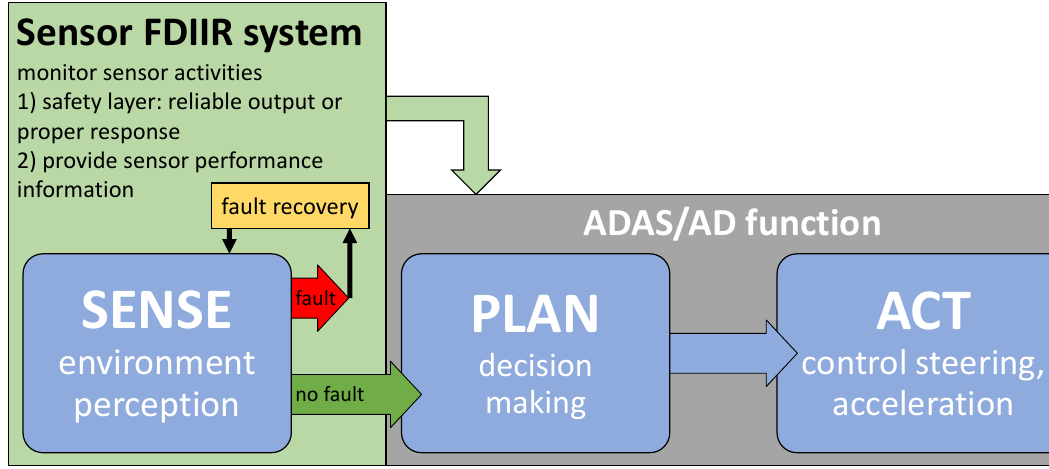
Figure 1. Schematic illustration of the sense-plan-act cycle including a sensor FDIIR (fault detection, isolation, identification, and recovery) system that monitors the sensor activity to ensure a reliable environment